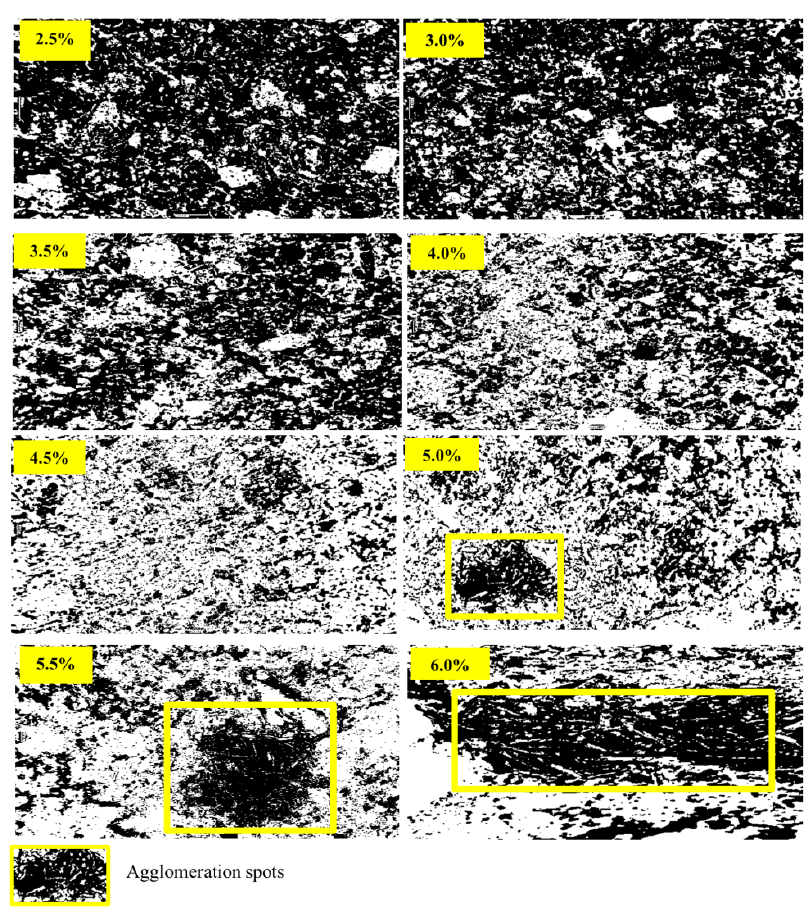
Figure 11. Beam cross-section images of CSWF distributions with ratios of 2.5% to 6%, cut hori-